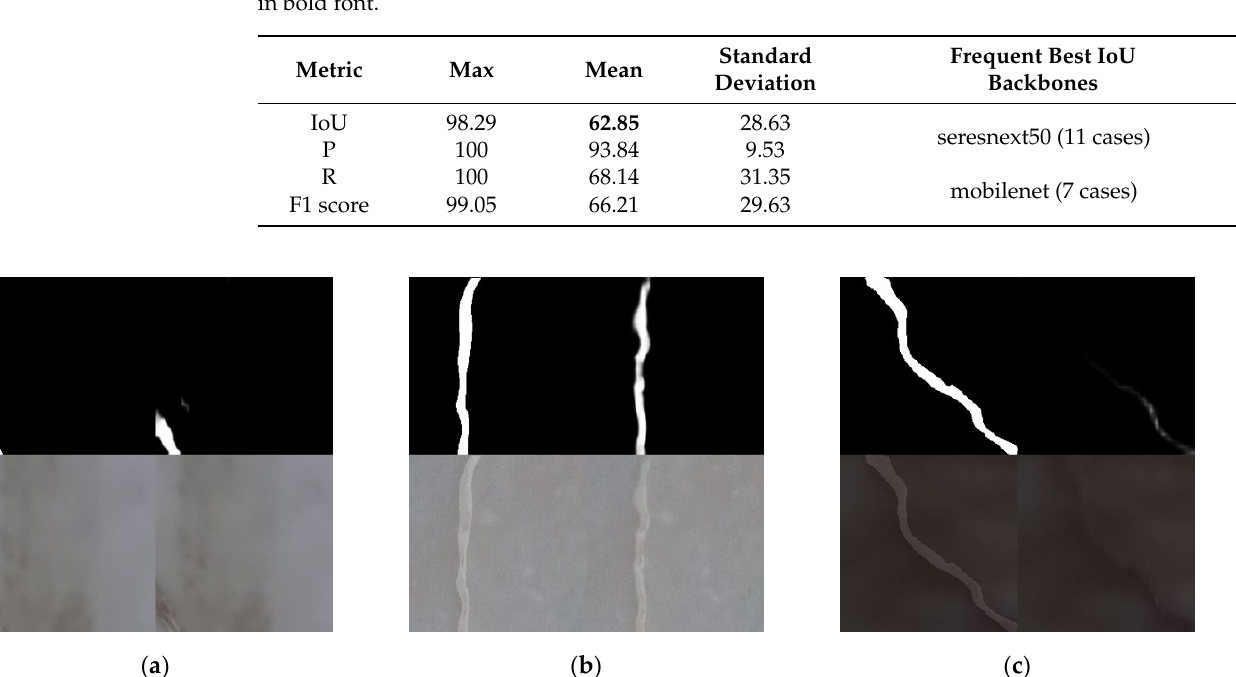
Table 5. Performance (%) of PSPNet on the test set after 5-fold cross-validation. Best mIoU is marked in bold font.